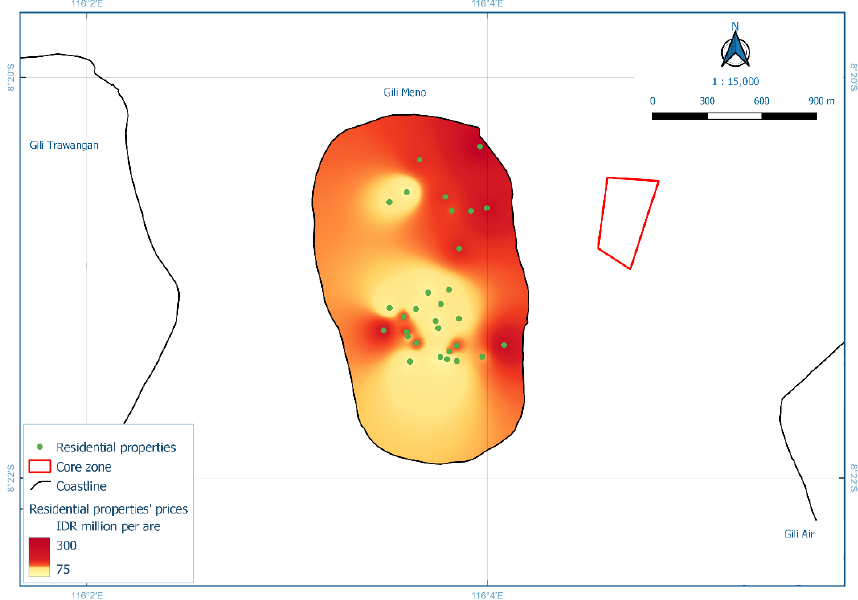
Figure 8. Interpolation of residential property prices for Gili Meno Island (Model